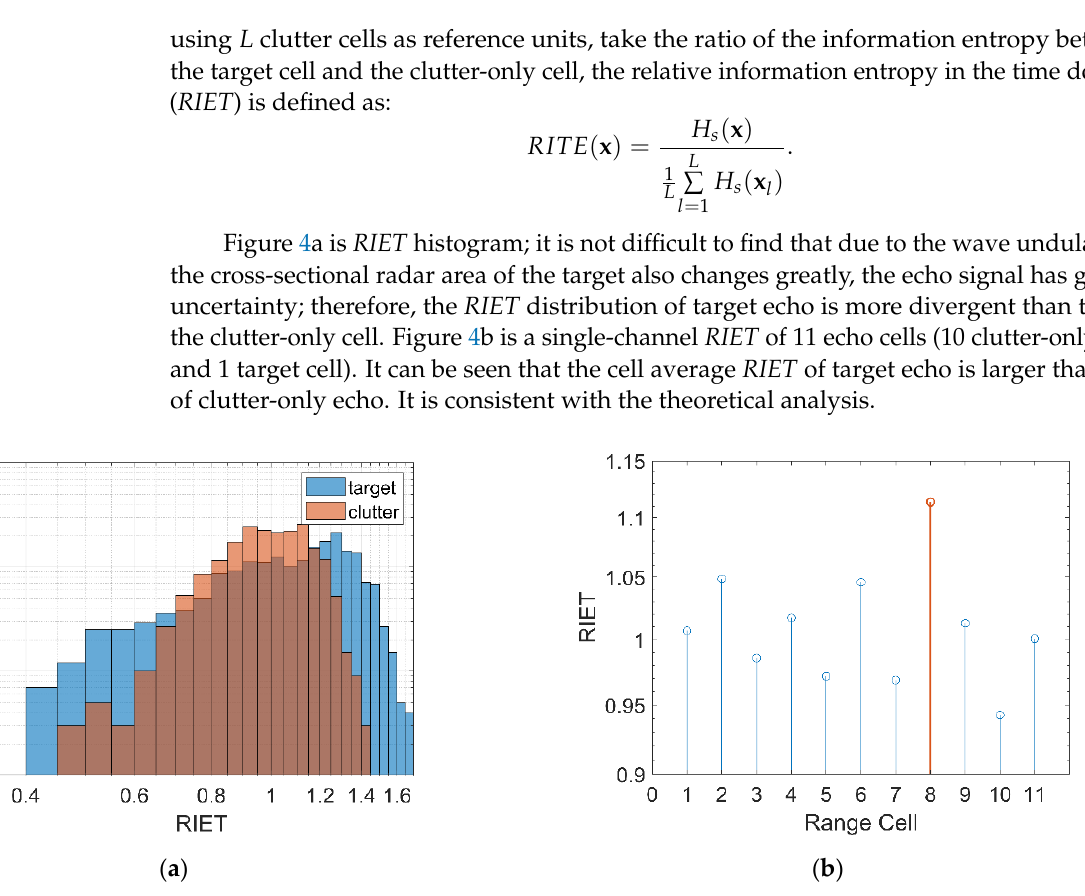
Figure 4. Relative information entropy in the time domain (RIET) feature of the first dataset. ( a ) the histogram of RIET at the primary cell where target exists and randomly selected clutter-only cell; ( b ) the average RIET of radar echo in each range cell.